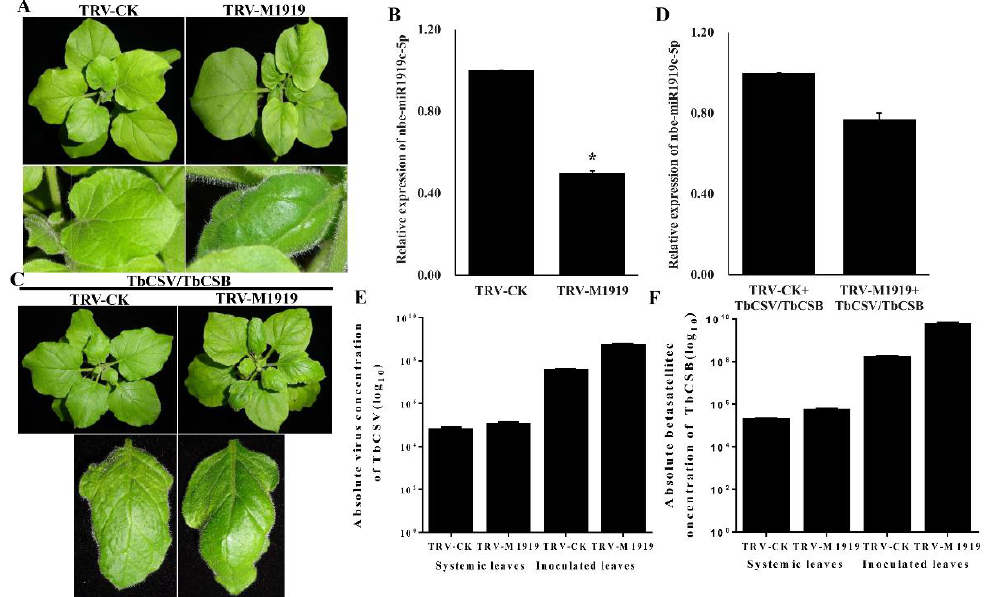
Figure 3. Suppression of nbe-miR1919c-5p expression using a TRV-based vector enhances leaf curling symptoms caused by TbCSV/TbCSB infection. ( A ) Plants inoculated with TRV or TRV-M1919 were photographed at 7 dpi. The TRV-M1919-inoculated plant showed stronger leaf curling symptoms compared with the TRV-inoculated control plants (TRV-CK). ( B ) Results of qRT-PCR showed that the expression of nbe-miR1919c-5p in the TRV-M1919-inoculated plants was significantly reduced compared with the control plants. ( C ) The TRV+TbCSV/TbCSB-inoculated and the TRV- M1919+TbCSV/TbCSB-inoculated plants were photographed 7 days after the second inoculation. The TRV-M1919+TbCSV/TbCSB-inoculated plants showed severe leaf curling symptoms. ( D ) Results of qRT-PCR showed that the expression of nbe-miR1919c-5p in the TRV-M1919+TbCSV/TbCSB- inoculated plants was significantly reduced compared with that in the TRV+TbCSV/TbCSB- inoculated plants. ( E ) Detection of TbCSV DNA copy number in the inoculated and the systemic leaves harvested from the TRV+TbCSV/TbCSB-inoculated or the TRV-M1919+TbCSV/TbCSB- inoculated plants. ( F ) Detection of TbCSB DNA copy number in the inoculated and the systemic leaves harvested from the TRV+TbCSV/TbCSB-inoculated or the TRV-M1919+TbCSV/TbCSB- inoculated plants. * P < 0.05 by the Student’s t -test.